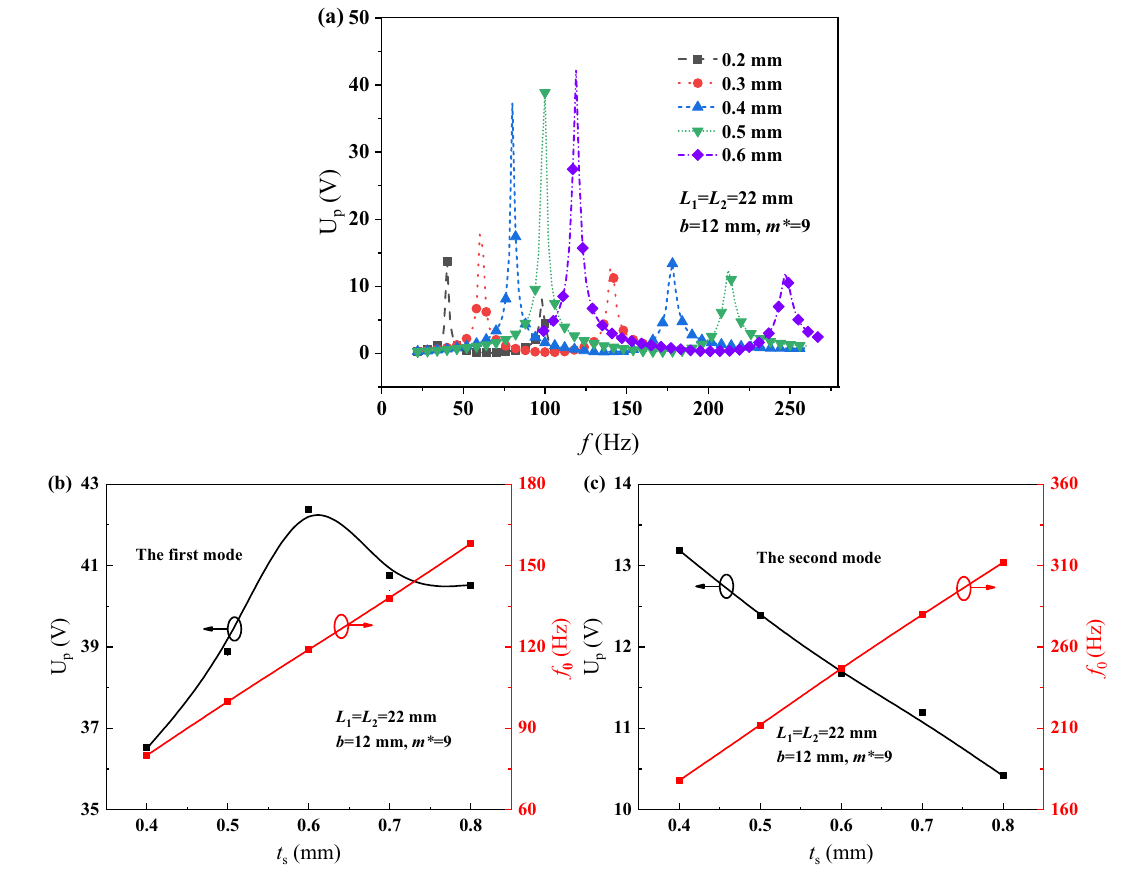
Figure 7. The U p - f curves ( a ), the U p-max and f 0 vs t s curves at the first ( b ) and second ( c ) modes of PEHDCB.